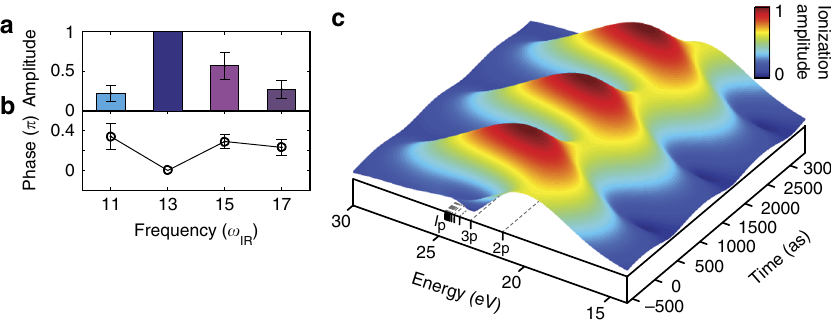
Fig. 4 Reconstruction of the ionization dynamics in strongly driven helium. Spectral a amplitude and b phase. We fi x the amplitude and phase of the frequency component at 13 ω IR since the absolute amplitude and phase of the wavepacket are unknown (error bars: standard deviation). c Time – energy (Gabor) representation of the ionized electron wavepacket build-up; ionization amplitude as a function of time and energy. The energy range of the ionization spans from about 9 eV below the fi eld-free ionization potential ( I p ) of helium to the continuum. We display the fi eld free excited p -state manifold of helium for orientation